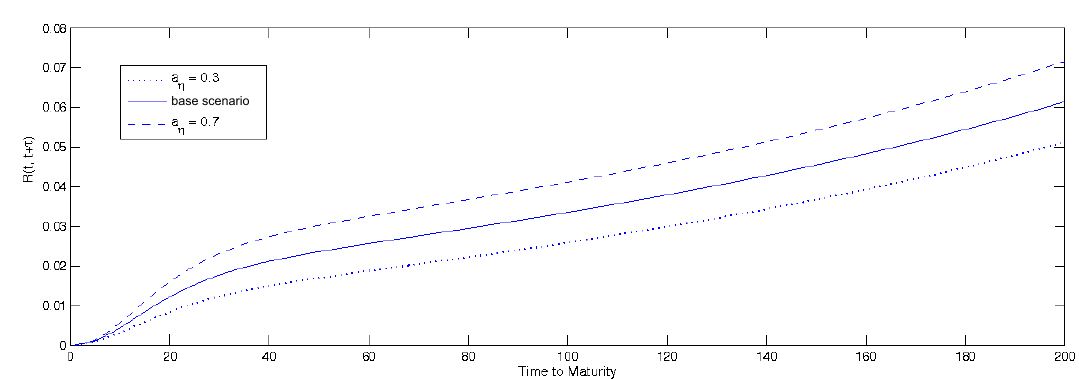
Figure 14. Short yield to various degrees of known-unknown uncertainty.